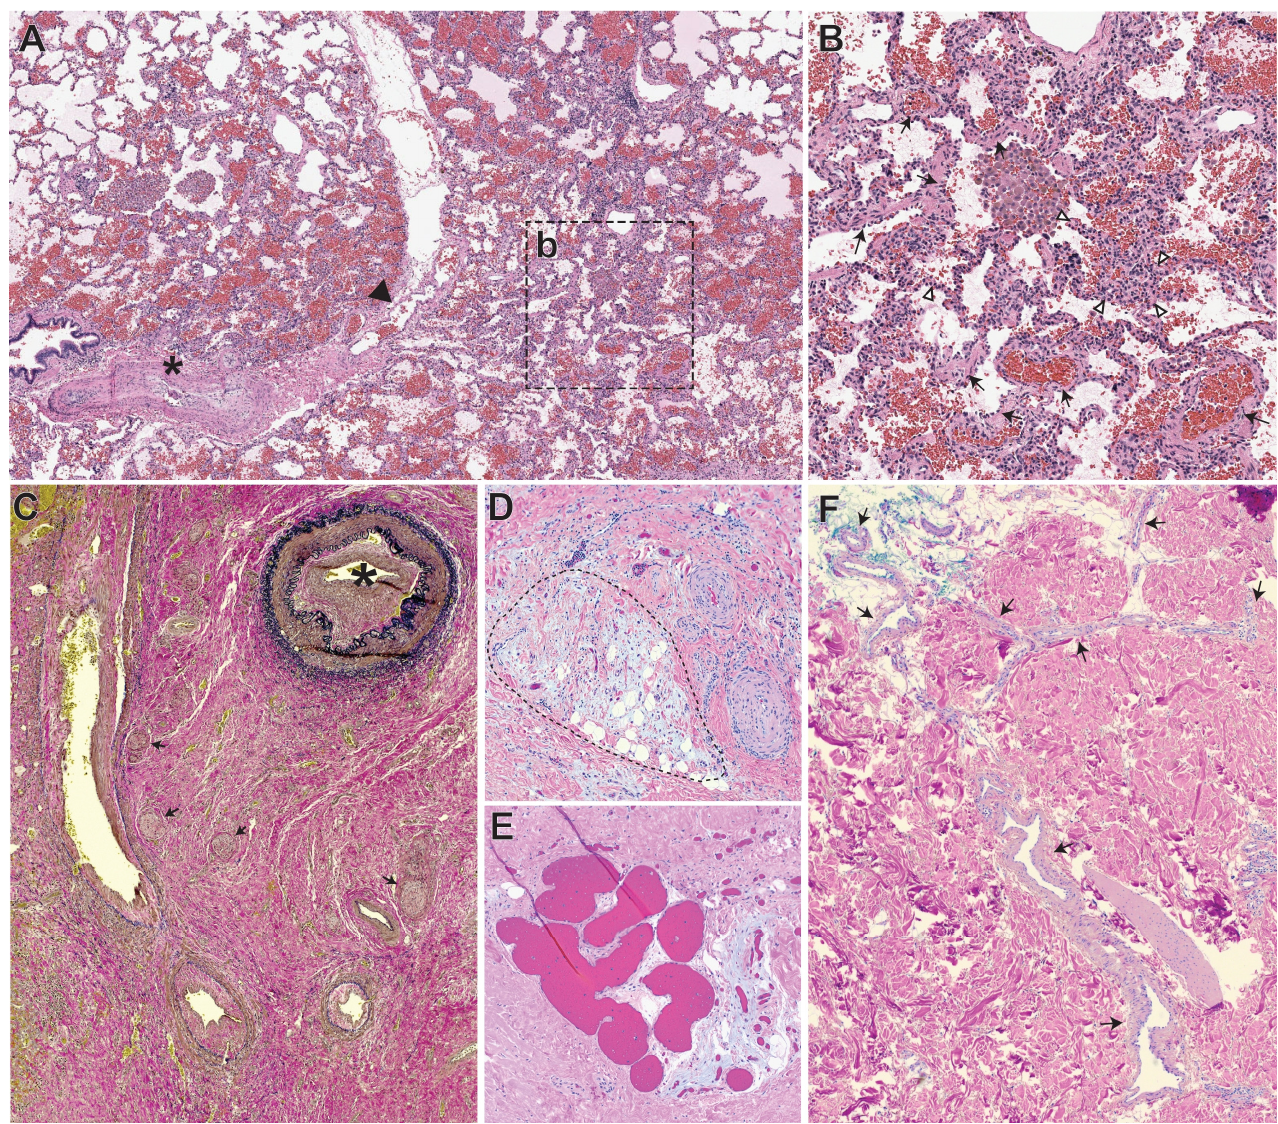
Figure 1. Examples of arteriovenous malformations (AVMs). ( A , B ) Arteriovenous malformation in the lung from a patient with hereditary hemorrhagic telangiectasia (HHT), ENG mutation, as well as pulmonary arterial hypertension (PAH), involving an artery with neointima (*) joining an interlobular septum containing pulmonary veins (arrowhead) ( A ). Adjacent to this fistula is a tangle of arterioles and venules (inset b is magnified in ( B )) embedded within the alveolar parenchyma. These small vessels (arrows) often have smooth muscle in their walls, distinguishing them from alveolar septae (white arrowheads) ( C ) Elastin van Gieson stain highlights haphazardly distributed elastic arteries in a PTEN-mutated hamartomatous vascular malformation. The largest artery in the top right (*) demonstrates evidence of turbulent flow including thickening of the elastic laminae, prominent intimal hyperplasia and narrowing of the lumen. Neural hyperplasia (arrows), seen in the background, is a frequent finding in PTEN-mutated lesions. ( D , E ) Striking foci of myxoid change (delineated with dashed line) ( D ) and clusters of thin-walled vessels with a honeycomb-like arrangement ( E ) are additional characteristic features of PTEN-mutated lesions in addition to the arteriovenous component. These foci ( D , E ) are from a PIK3CA-mutated vascular malformation, which can show overlapping features with PTEN-mutated lesions. ( F ) Sporadic cutaneous AVM with a MAP2K1 variant, showing a web of arterioles and venules (arrows). Note that the changes in the vascular wall are subtle, suggesting lower grade